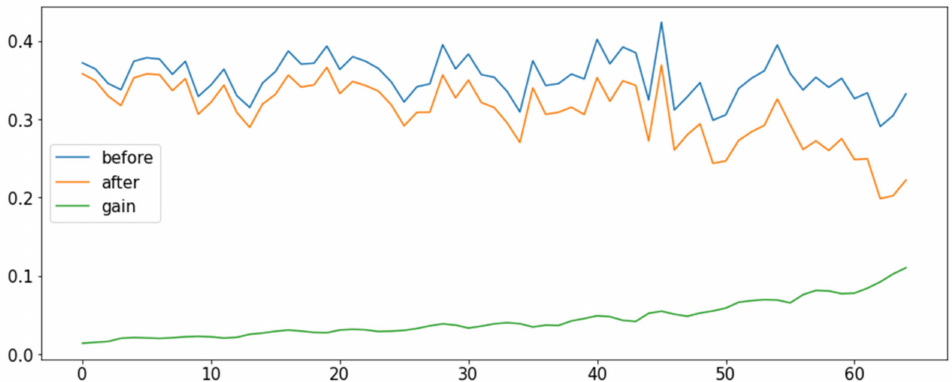
Figure 12. Monthly evaluated proposed accuracy gain determined through beam search algorithm. Before means net load forecasting without BTM pattern. After means the maximal improvement at target month. X axis means month between Jan 2015 to Aug 2020. Y axis means the expected